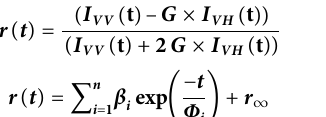
Chol in 1:1:1:1 mol ratio - the mixture that mimics the membrane of normal mammalian cells ( N-model ) and POPC:POPE:SM: Chol 36.2:23.6:6.8:33.4 mol ratio, the mixture that mimics the membrane of U-118 cancer cells ( C-model ) (Barceló-Coblijn et al., 2011; Khmelinskaia et al.,